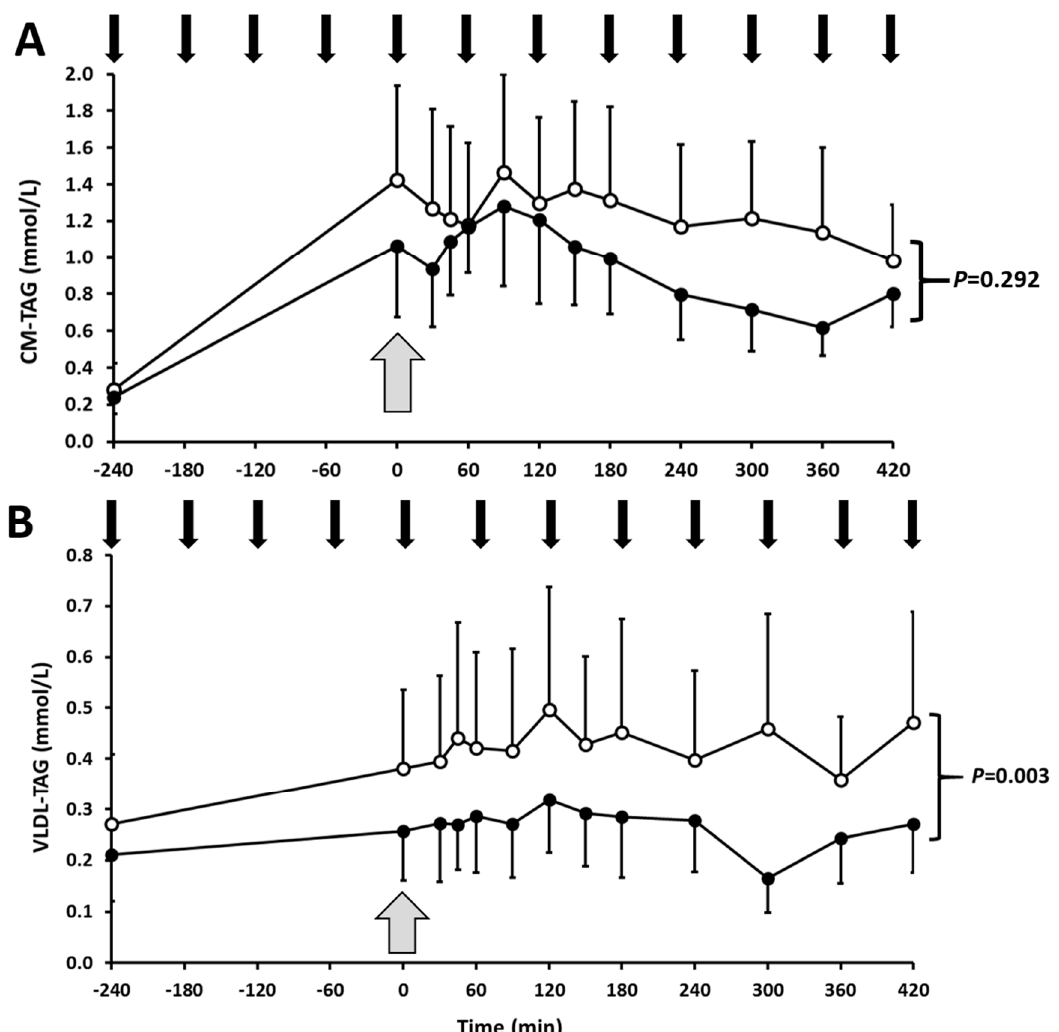
Figure 3. CM-TAG ( A ) and VLDL-TAG ( B ) responses to high- or low-fructose drinks. Subjects consumed high-fructose (white circles) or low-fructose (black circles) drinks every hour (black arrows) from fasted ( − 240 min) to achieve a steady postprandial state (0 min; grey arrow), at which time a bolus of [ 2 H 5 ]-glycerol was administered to measure lipoprotein TAG kinetics (0–420 min). Data are mean ± SEM ( n = 5). Time course responses were analysed by a linear mixed model to determine the treatment effect: for CM-TAG; P = 0.292 (NS); for VLDL-TAG P = 0.003. CM, chylomicron; TAG, triacylglycerol; VLDL, very low-density lipoprotein.